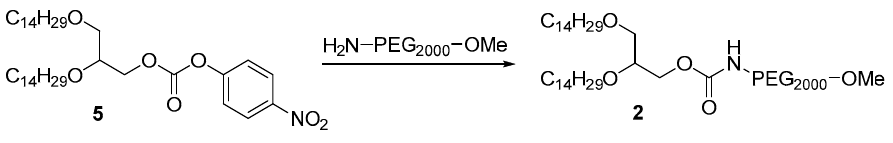
Figure 1. Chemical structure of PEG-containing